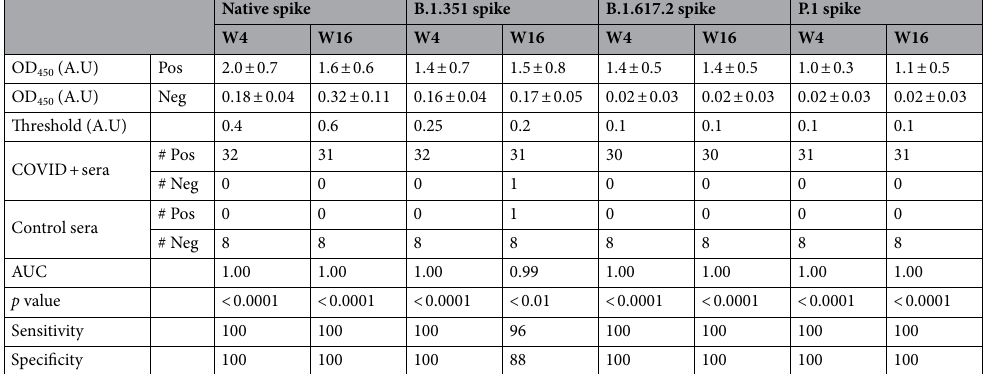
and negative samples (sensitivity = 100%, specificity = 100%, Tables 1, S1, S2, Figs. 1, S1). ELISA results showed no difference among individuals with a positive test result, whether their second PCR test result was negative or positive at the time of enrollment (14–21 days post diagnosis, Fig. S2). The SPR assays also performed well for the native spike protein (AUC = 0.99 and p < 0.0001), correctly identifying all samples with the exception of one positive sample which tested negative at week 4 (sensitivity = 97%, specificity = 100%, Tables 2, S3, S4). Whereas the OD 450 decreased by approximately 20% from weeks 4 to 16 for the native spike protein, the SPR binding shift did not change significantly (Fig. 1). The ELISA OD 450 and the SPR shift tended to decrease for B.1.351, B.1.617.2 and P.1 at weeks 4 and 16 in comparison to the native spike protein, the greatest difference being week 4 (Figs. 1, S1). As a result, a few positive samples tested negative when SPR assays were conducted with the B.1.351 spike